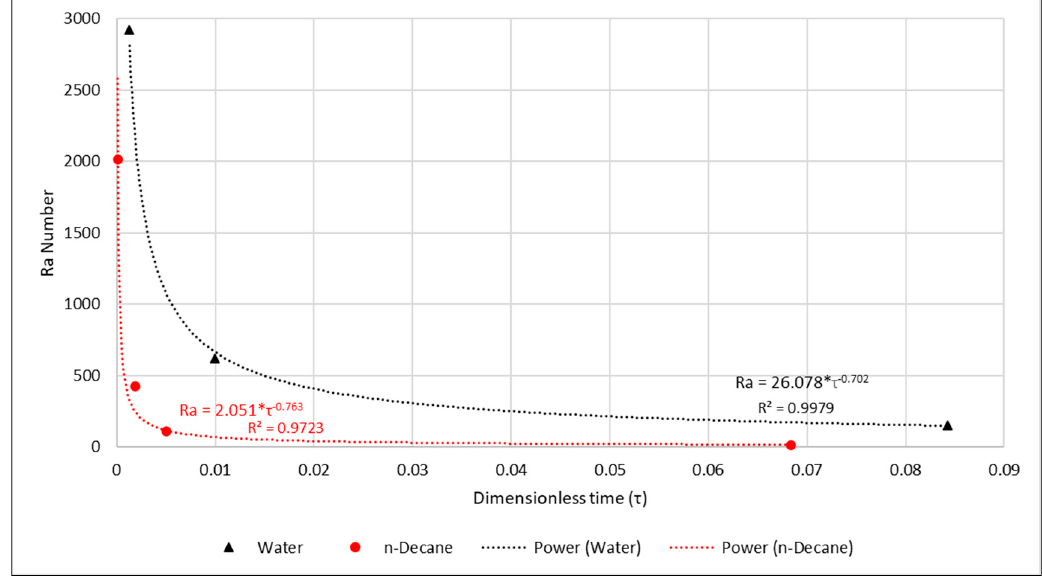
Figure 11. Ra number as function of dimensionless time for n -decane and water-saturated 3-dim porous media.